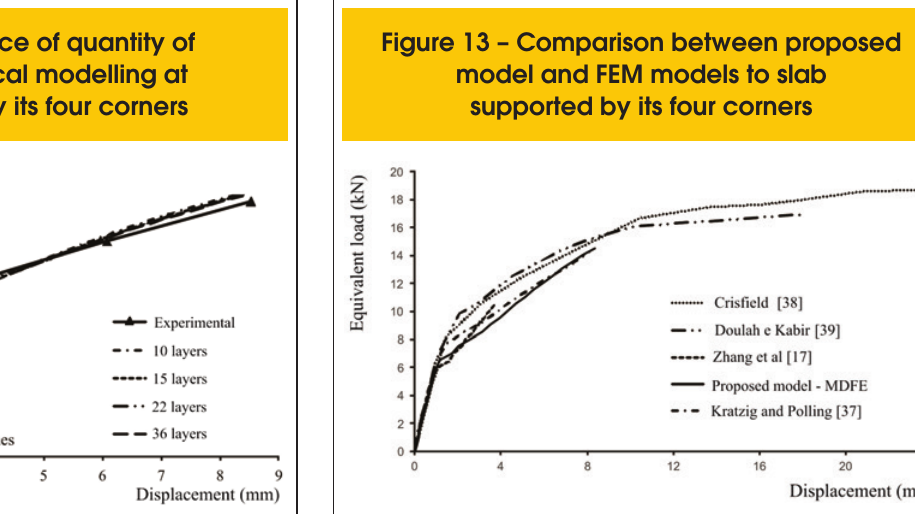
Figure 12 – Influence of quantity of layers on numerical modelling at slab supported by its four corners